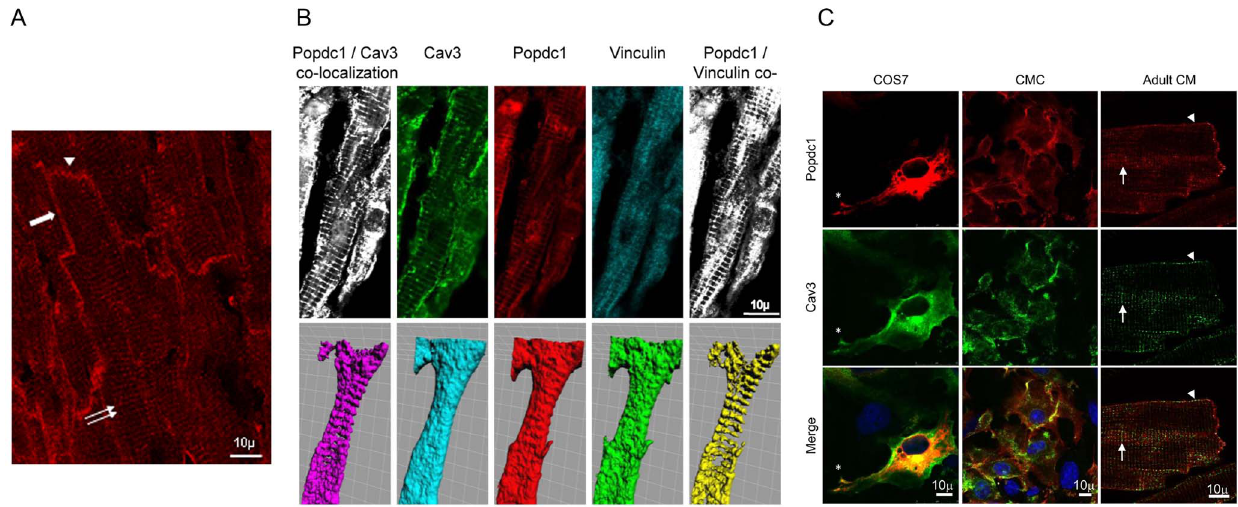
Figure 1. Localization of Popdc1 in WT cardiomyocytes. (a) Popdc1 (red labeling) is evident at the lateral membrane (arrow), intercalated discs (arrowhead) and transverse striations (double arrow). (b) Upper panel, co-labeling for Popdc1 (red), Cav3 (green) and vinculin (light blue); on the left, merge of Popdc1 with Cav3 (white) and on the right, merge of Popdc1 with vinculin (white). Lower panel, 3D surface analysis based on Z-stack pictures. Popdc1 (red), Cav3 (light blue), vinculin (green), merge of Popdc1 with Cav3 (violet), merge of Popdc1 with vinculin, yellow. Square size 5 6 5 m m. (c) Popdc1 (red) and Cav3 (green) co-localize (yellow) in the sarcolemma (arrowhead) and T-tubules (arrows) in isolated adult WT cardiomyocytes (Adult CM), at sites of cell-cell contacts in cultured neonatal WT cardiomyocytes (CMC), and in Popdc1/Cav3 co-transfected COS7 cells at sites of cell adhesion (Asterisk) and inside the cells.